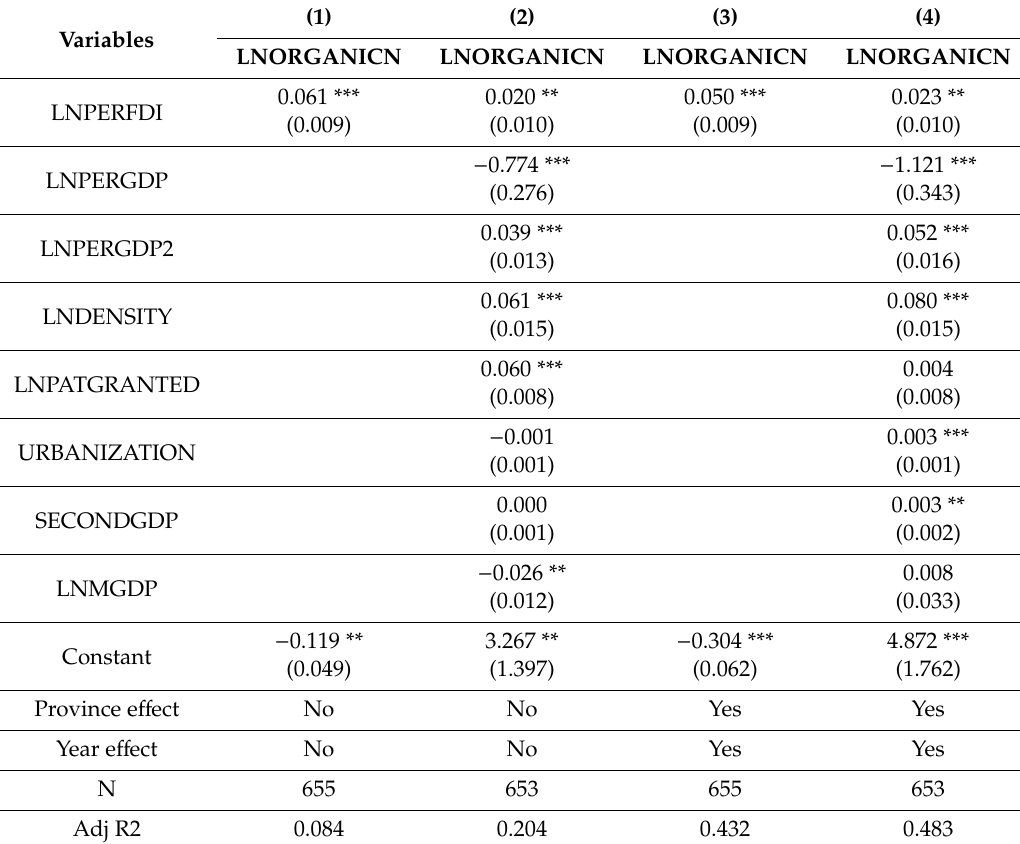
Table 2. Estimation results of the entire